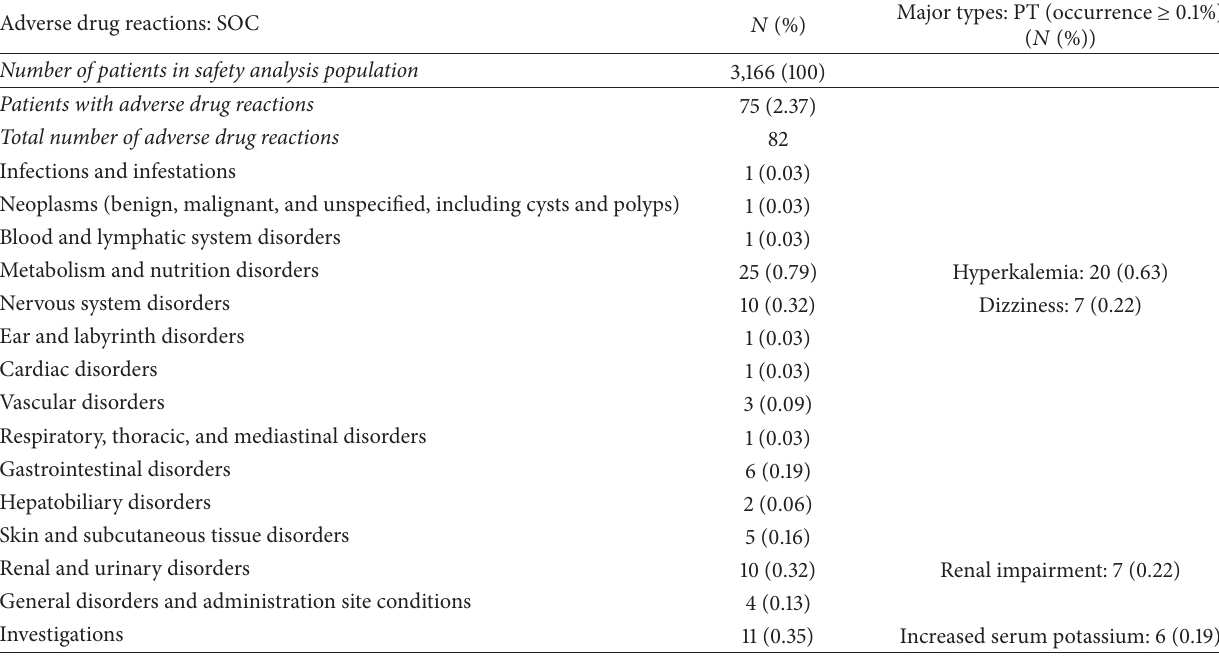
Table 2: Incidence of adverse drug reactions in safety analysis population.